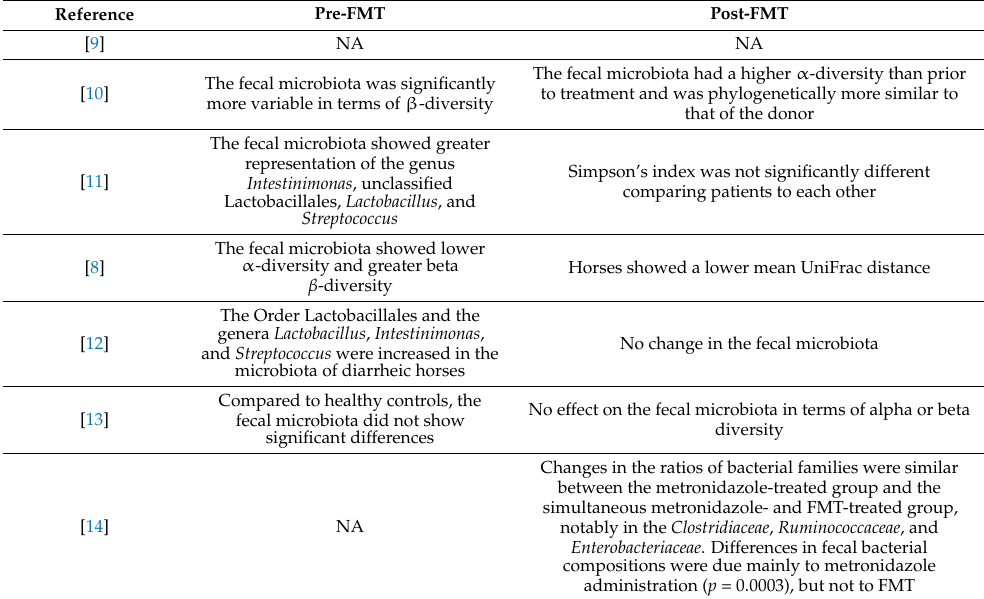
Table 3. Changes of the equine gut microbiota compositions in the included